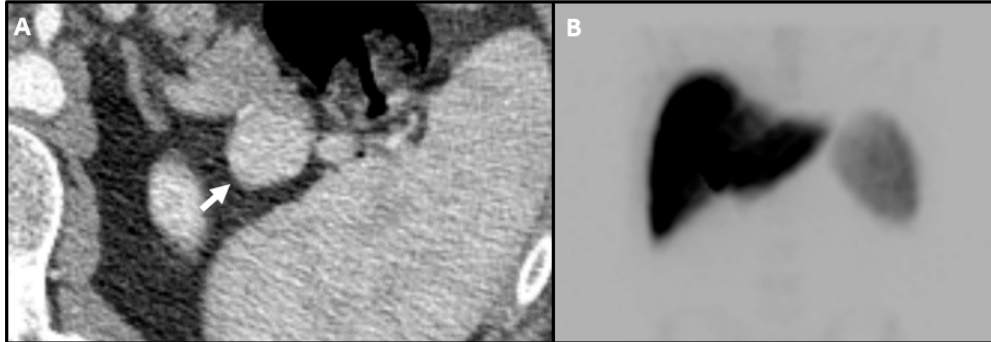
Figure 3. Mass adjacent to pancreatic tail. ( A ) Axial CT image shows an ambiguous enhancing mass (arrow). It is unclear whether this mass is intra- or extra-pancreatic and splenule was raised as a possibility. ( B ) Frontal planar 99m Tc-Sulfur Colloid image without focal uptake in the region of the pancreatic tail, making splenule unlikely. This mass was surgically excised and confirmed to be an insulinoma.